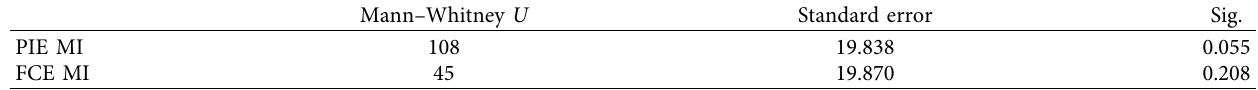
Table 10: Hypotheses testing for the Malmquist Indexes.